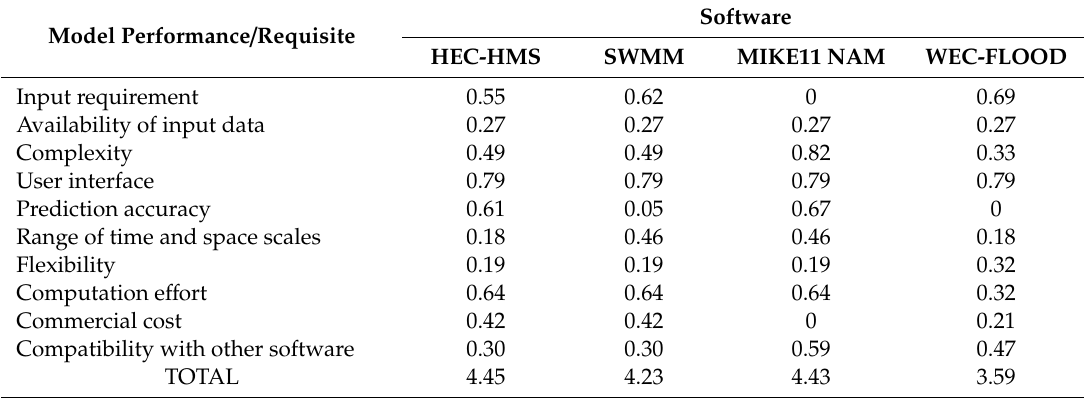
Table 6. Weighted scores for the 10 parameters used for calculating the model evaluation matrix of the four hydrological computer models tested in the Mesima torrent (Calabria, Southern